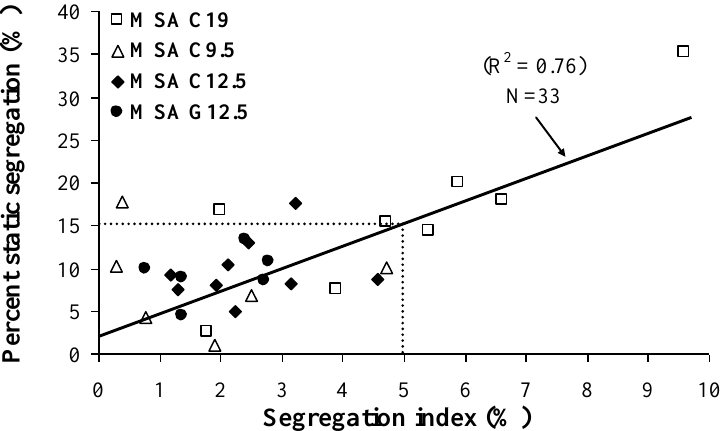
Figure 6. Relationship between column segregation index (C.O.V.) and percent of static of segregation (S).